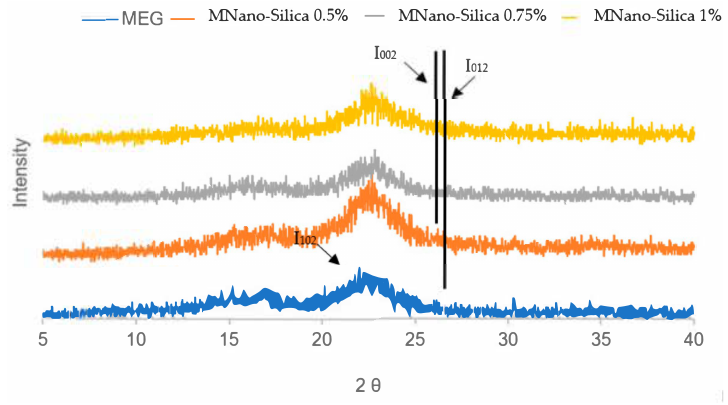
Figure 3. XRD spectra of sengon wood after impregnation